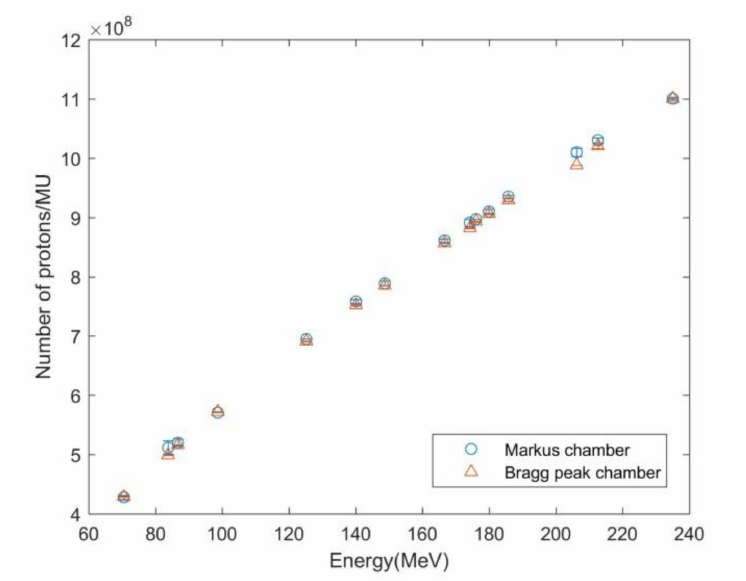
Figure 7. Number of protons per MU as a function of nominal proton beam energy derived from Markus chamber and Bragg peak chamber